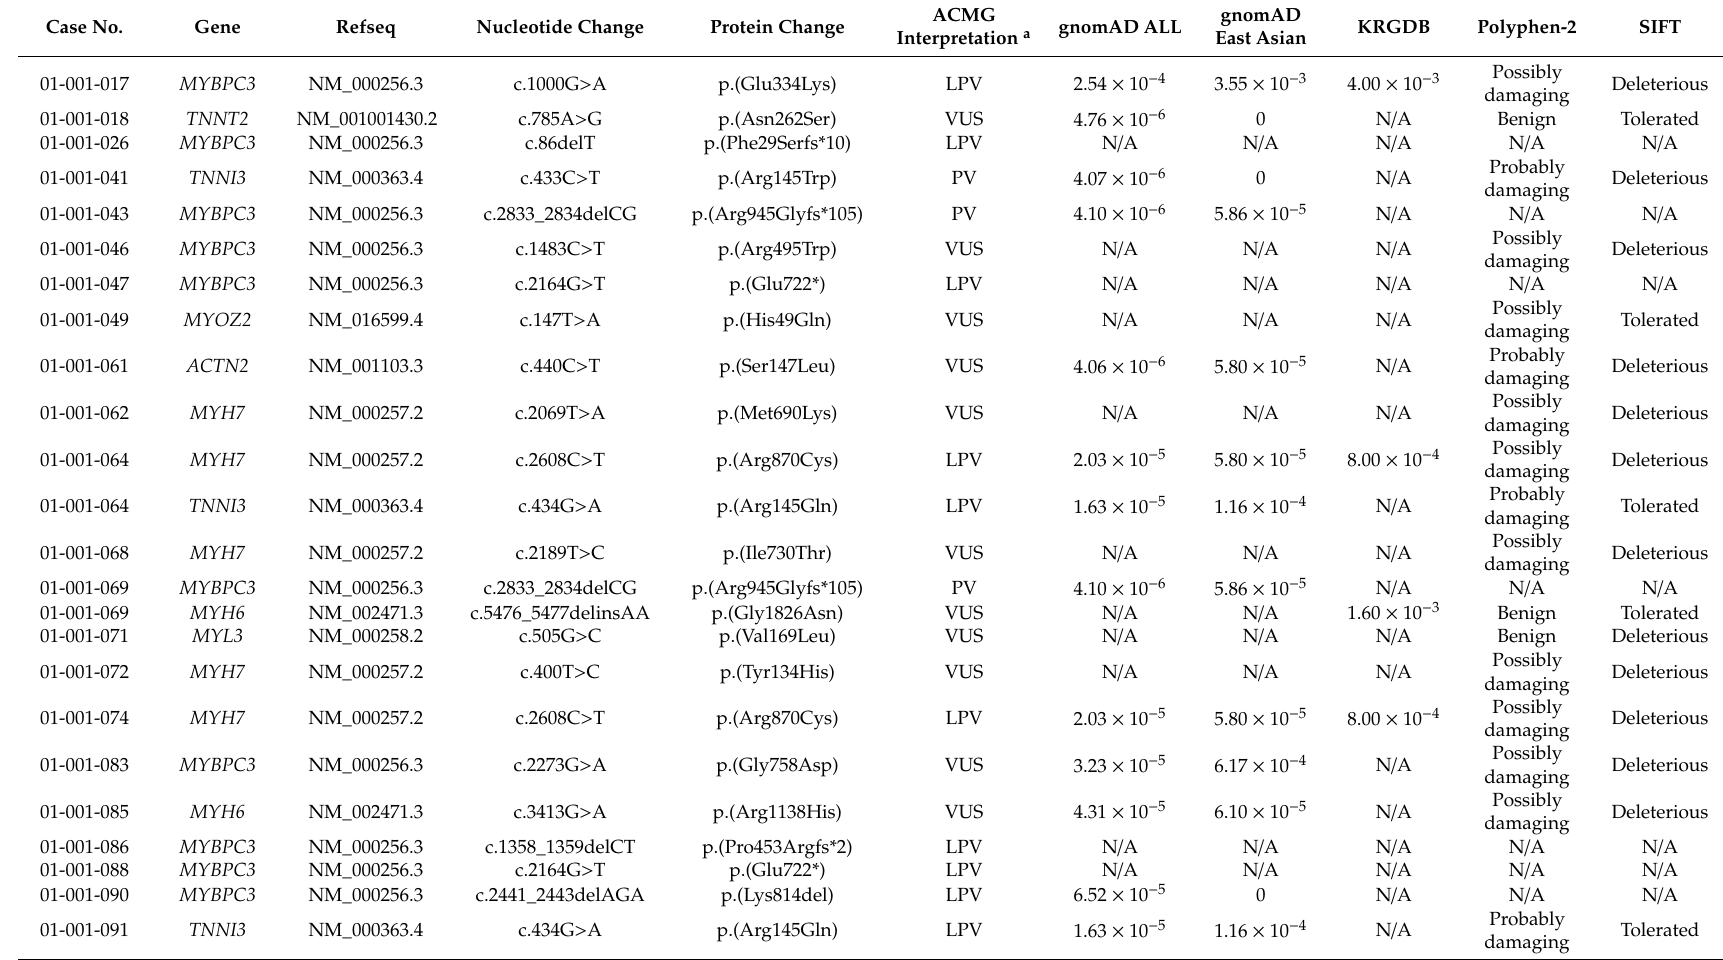
Table 3. Pathogenic variants, likely pathogenic variants, and variants of uncertain significance in 23 sarcomeric and non-sarcomeric genes of hypertrophic cardiomyopathy